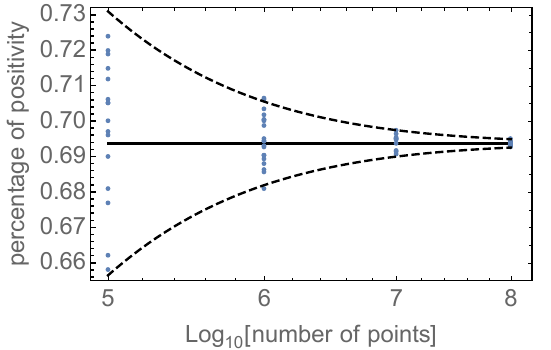
Figure 2 . Percentages of the parameter space, or solid angle Ω( C el ) , of analytical elastic positivity A bounds, eqs. (4.127) – (4.140) , computed from different samplings ( 10 5 , 10 6 , 10 7 or 10 8 points). Each blue point is a sampling. The horizontal axis is the number of sampling points, while the vertical axis is the resulting Ω( C el ) . The solid line (0.6937%) is the average of 15 largest samplings, each A with 10 8 points, while the dashed lines are 2 σ